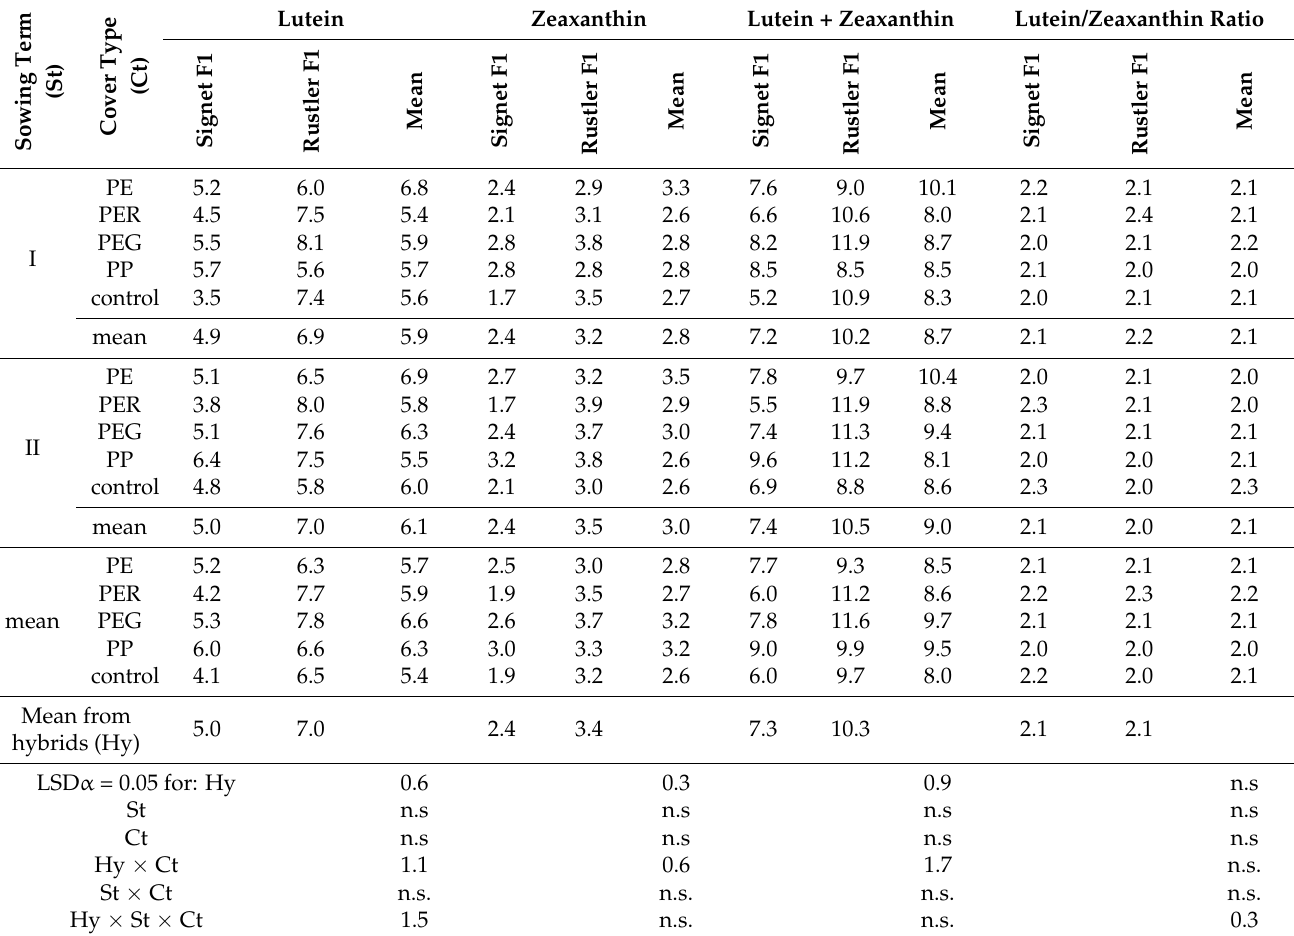
Table 3. Total cobs yield (dt per ha) and percentage (%) of marketable cobs yield. Average from years 2012–2014. Table 5. The effect of treatments on carotenoid content in maize grain ( µ g per g of fresh grain). Average from year 2012.